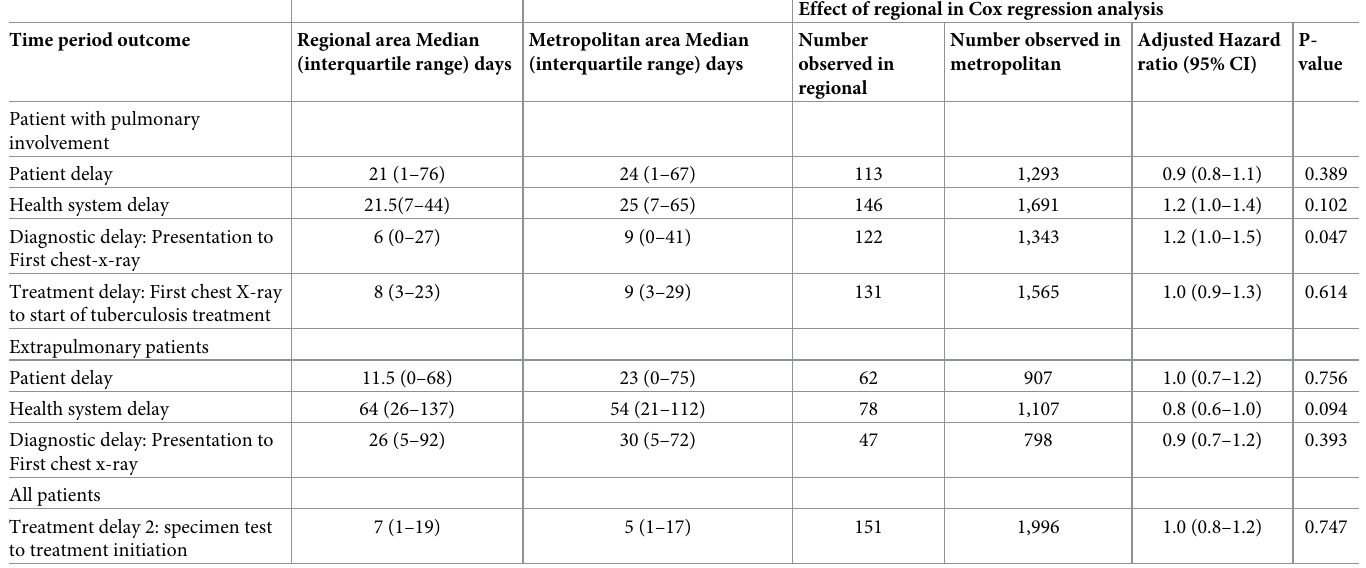
Table 4. Adjusted relationship between regionality in Cox regression models of delays in the cascade of care among tuberculosis patients in Victoria from 2012 to